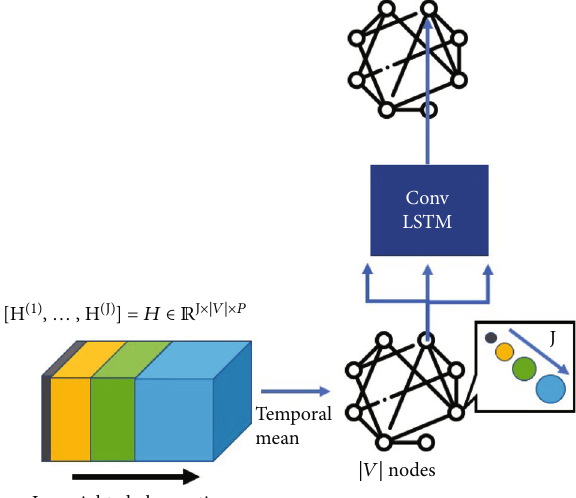
Figure 5: Contextual gating